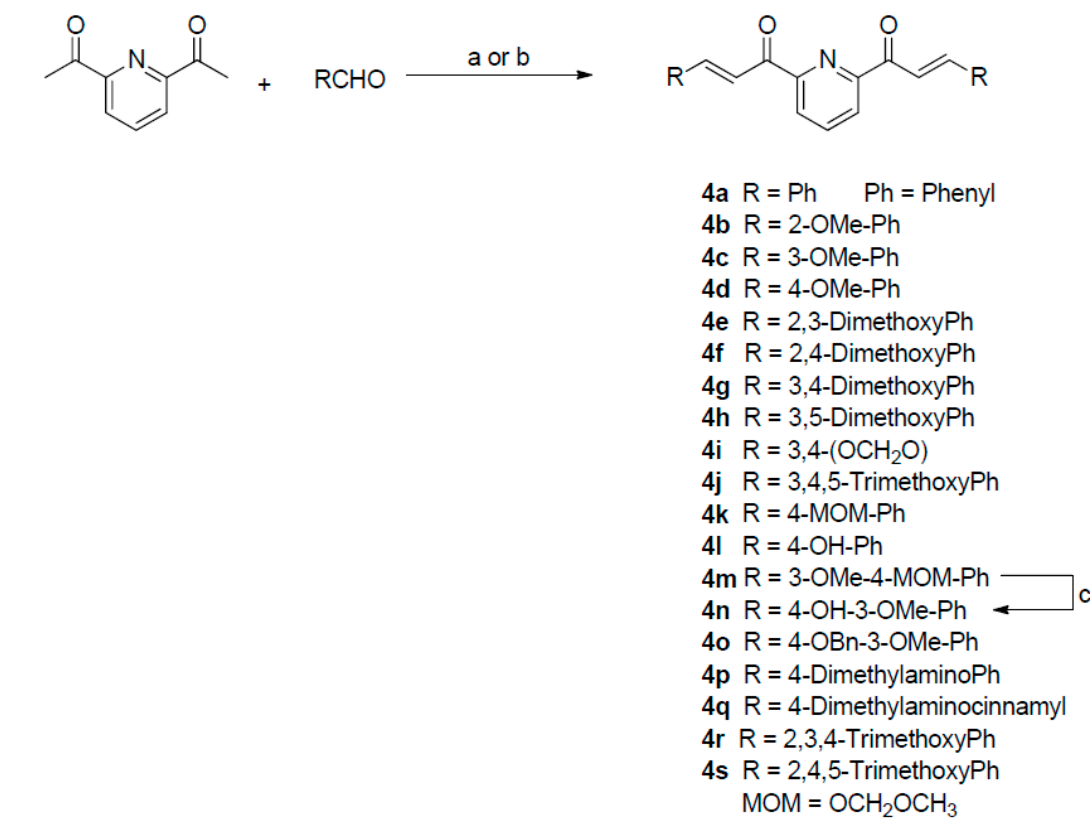
Figure 1. Reaction scheme for the synthesis of bis-chalcones a . a Reagents and conditions: (a) 20%NaOH, 113 MeOH, RT; (b) cat. Piperidine, MeOH, ref lux; (c) Trifluoroacetic acid/conc. HCl, 114 Dichloromethane. 115